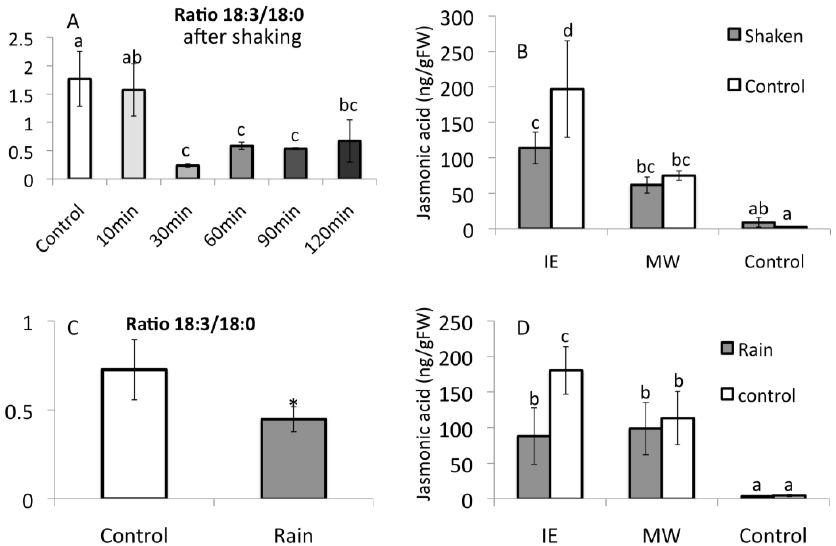
Figure 9. Effects of plant movements on free fatty acid levels and jasmonic acid accumulation. ( A ) Effect